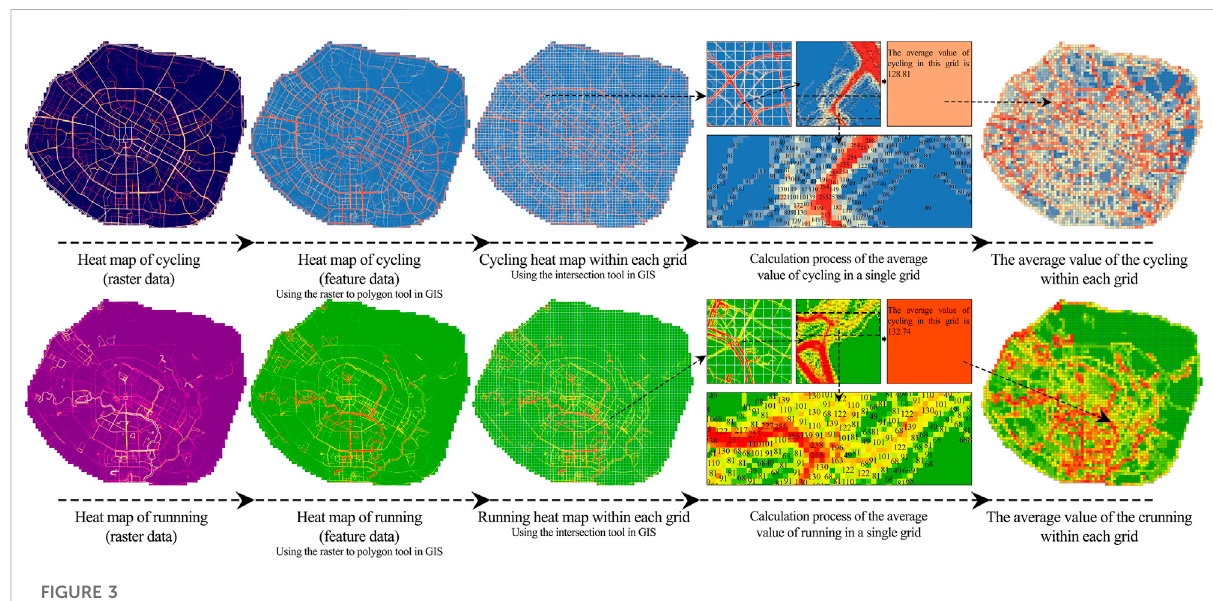
FIGURE 3 Illustration of the calculation of the cycling and running index in each